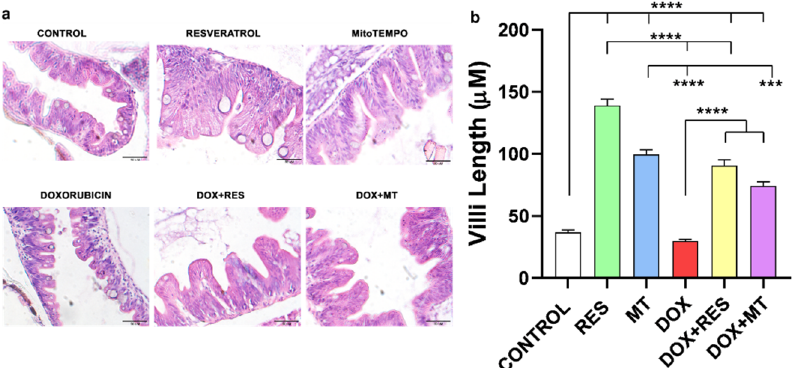
Figure 2. Histology of zebrafish gut. Total of 30 dpf zebrafish guts sections was stained with H&E to observe the villi from the different treatment groups with resveratrol (RES), MitoTEMPO (MT) and doxorubicin (DOX) ( a ). Length of villi ( b ). Statistical significance was calculated using Tukey’s multiple comparison (one-way ANOVA) [*** p ≤ 0.001, **** p ≤ 0.0001] [N = 5 ×